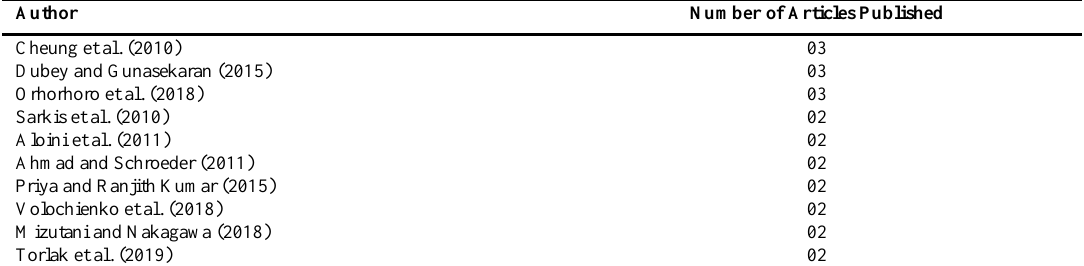
Table 8. Top 10 authors: intellectual capital and operational